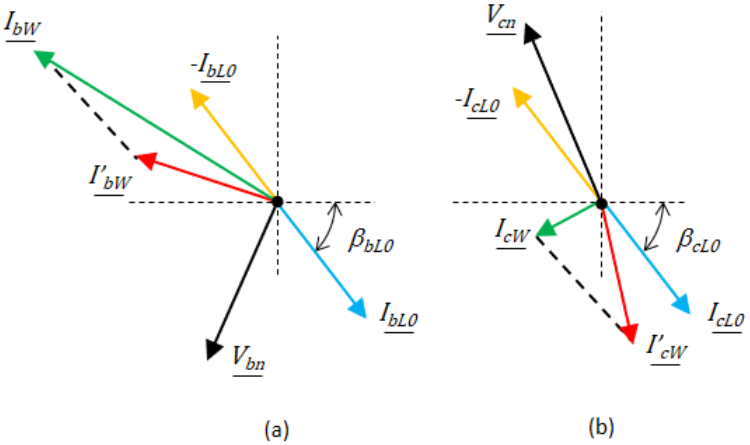
Figure 5. Vector diagram referring to phases B and C. ( a ) for phase B and ( b ) for phase C.